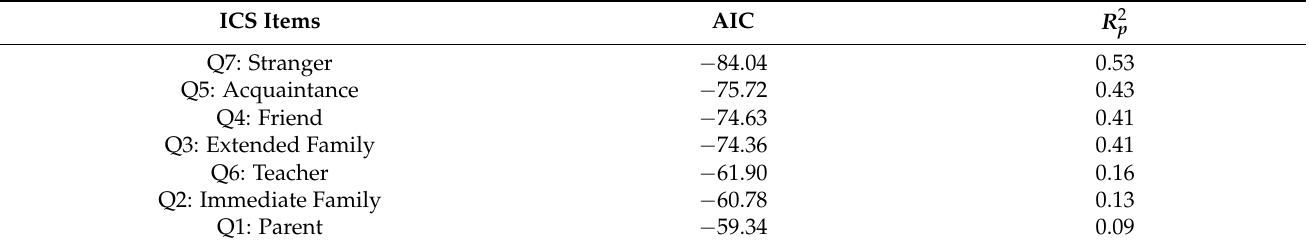
Table 3. AIC and pseudo R-squared value of beta regression models.